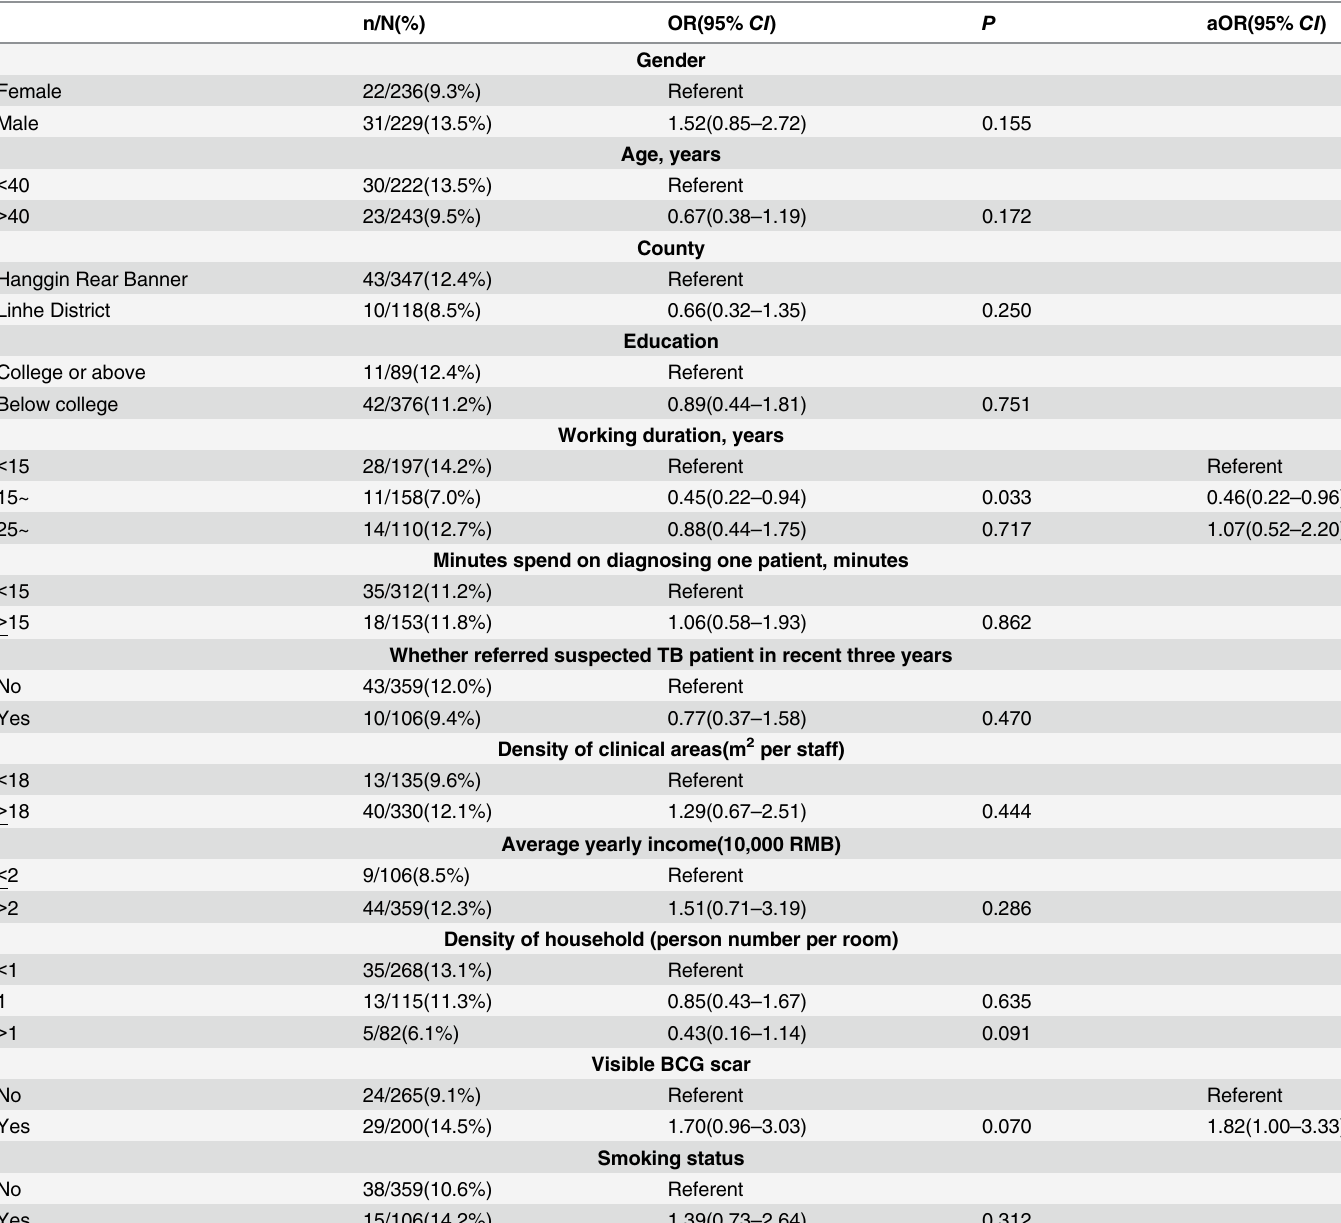
Table 5. Factors associated with LTBI conversion detected by TST (n = 465) *